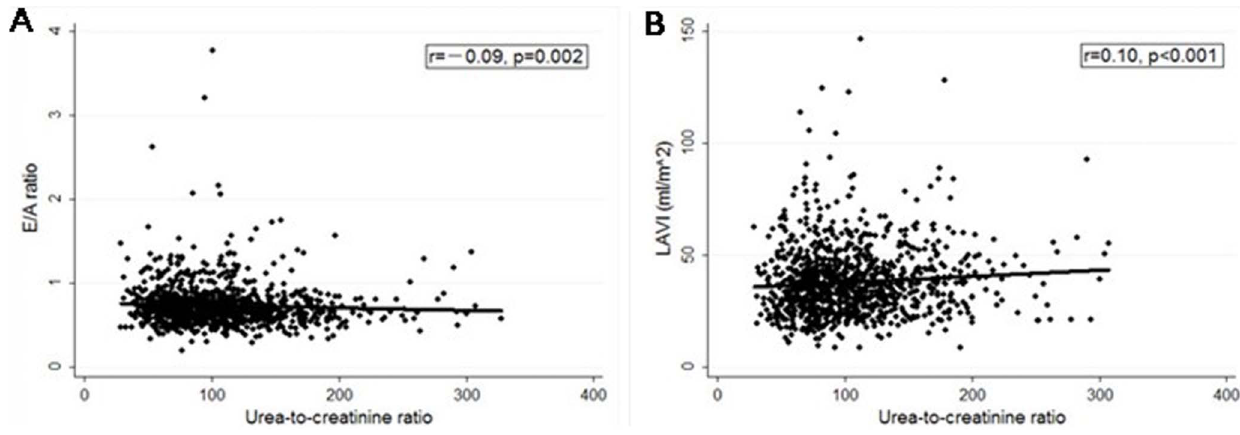
Figure 3. Relationship between urea-to-creatinine ratio and echocardiographic indexes (E/A and LAVI). A ) Urea-to-creatinine ratio was negatively correlated to E/A ratio. B ) Urea-to-creatinine ratio was positively correlated to LAVI. LAVI, left atrial volume index.